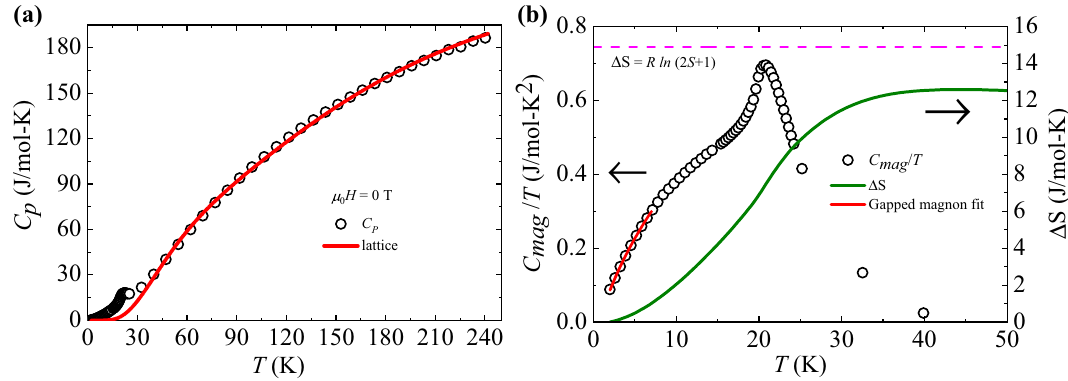
Figure 3. ( a ) The temperature dependence of specific heat C p ( T ) of polycrystalline samples of BMTO in the temperature range 2 K T 250 K at zero applied field. The solid line is the fit of C p ( T ) data to Debye ≤ ≤ Einstein model accounting for the lattice contribution to specific heat. ( b ) The temperature dependence of magnetic specific heat ( C mag ( T )/ T ) of BMTO in the temperature range 2 K calculated entropy change with temperature (right